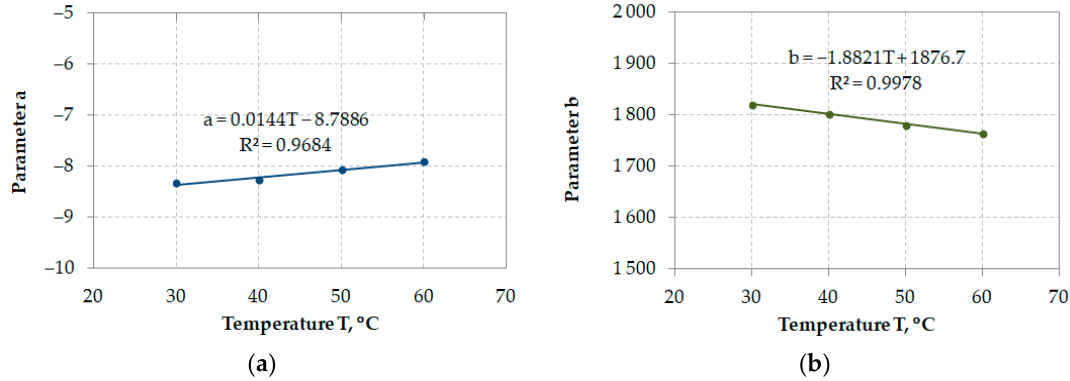
Figure 7. Parameters a and b depending on temperature (trimmer immersed in a mixture of mineral oil and synthetic ester).